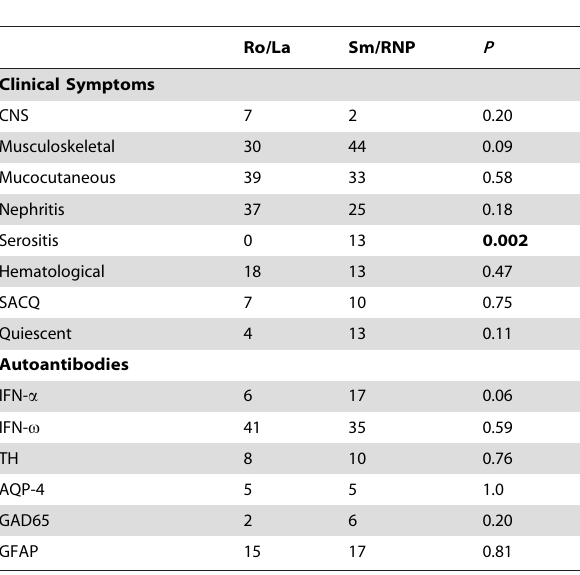
Table 3. Percentage of patients in each cluster with specific clinical manifestations and